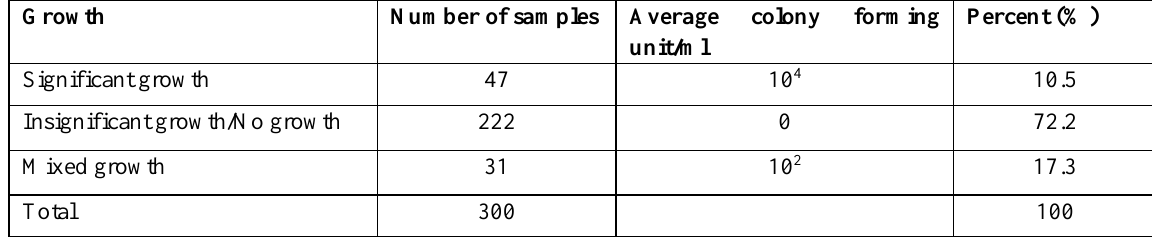
Table 1. Growth patterns of urine culture among the university